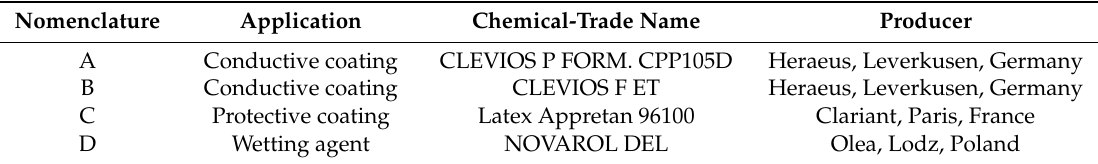
Table 2. List of chemicals for textile sensor production.